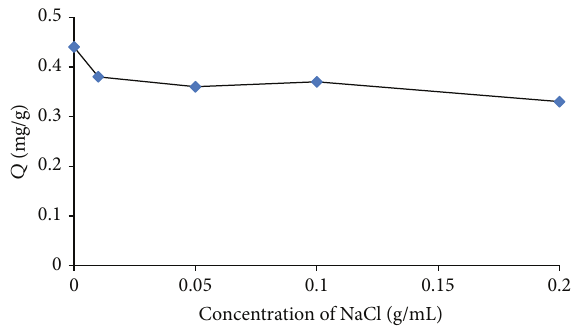
Figure 3: Effect of temperature on the extraction efficiency ( 𝑄 ) of Sr 2+ . Extraction conditions: absorption time 20 min, pH 7, and stirring rate 600rpm.